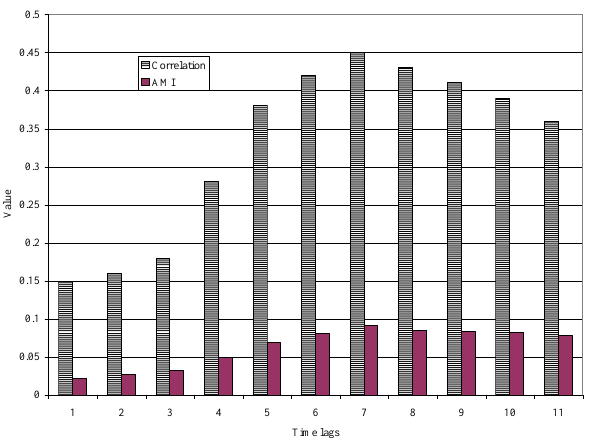
Fig. 2. Average mutual information and correlation of inputs-output for the evapotranspiration case study.